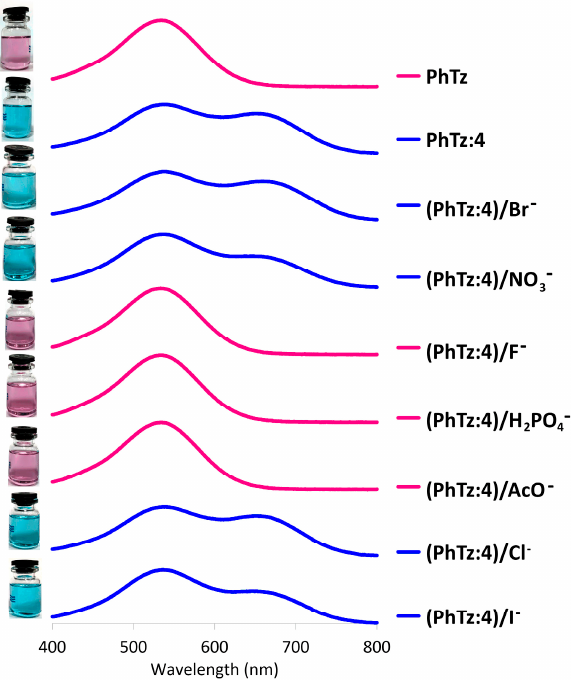
Figure 3. Absorption spectra of PhTz:4 complex (C = 1 × 10 -5 M, PhTz:4 , ratio 1:1) in the presence of the tetrabutylammonium salts (C = 1 × 1 0 − 4 M) and photographs of corresponding